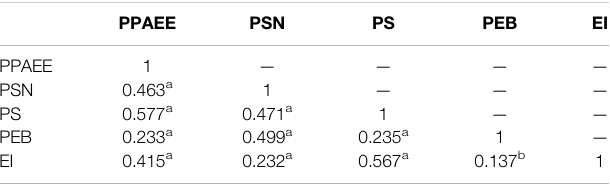
TABLE 4 | Summary of principal component analysis of the